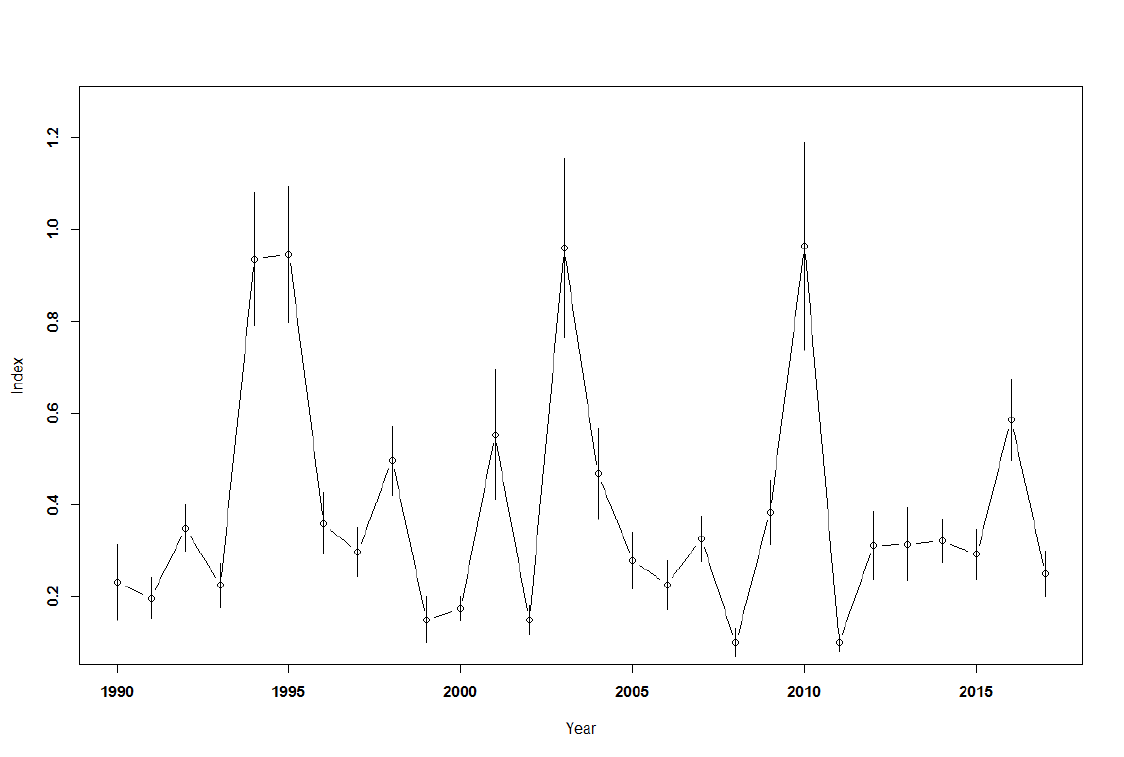
Figure 62. Index of relative abundance of horseshoe crab (delta mean catch per tow) developed from the spring portion of Maryland’s Coastal Bays Survey with 95% confidence